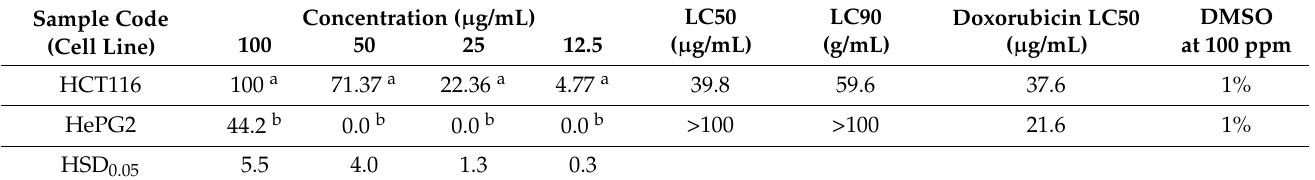
Table 15. Cytotoxic activity of Thymus algeriensis essential oil against human cell lines (% of inhibition cells ± SEM). Sample Code